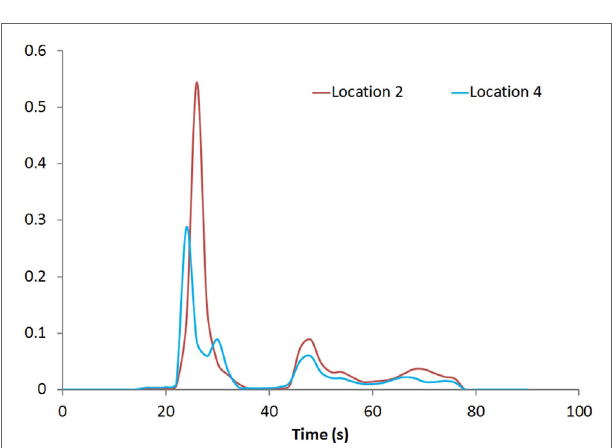
FigUre 3 | Tissue residue functions at locations 2 and 4 . Both the first-pass [20s, 40s] and second-pass [40s, 60s] of the function are well